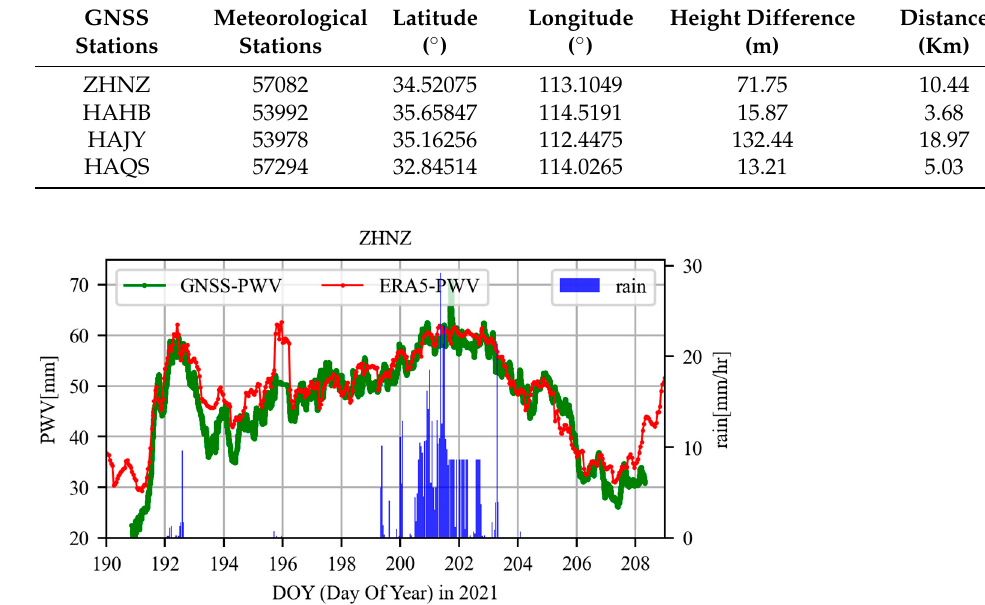
Figure 4. GNSS stations and the meteorological station used for the analysis. Table 3. Location of GNSS stations and their relative elevation/distance to the meteorological station.